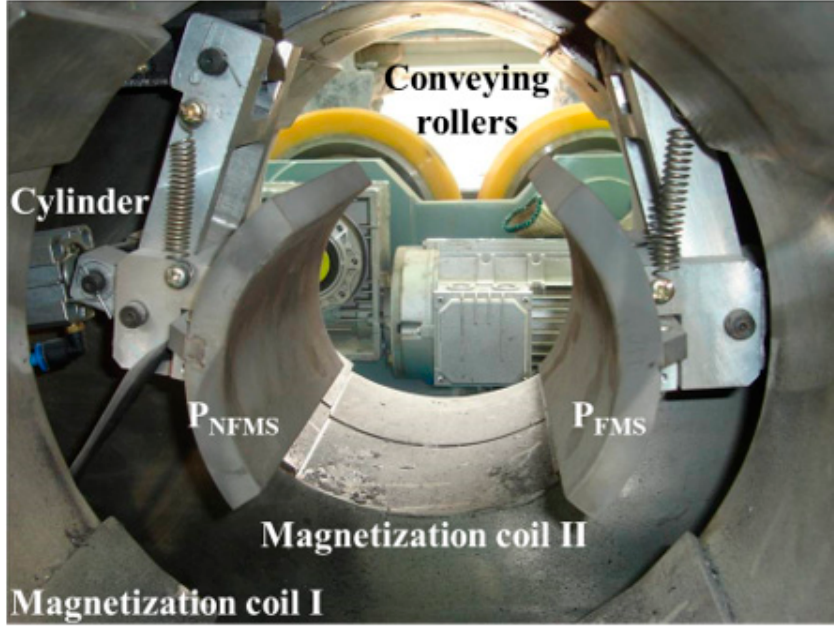
Figure 10. The MFL probing system for steel pipe.